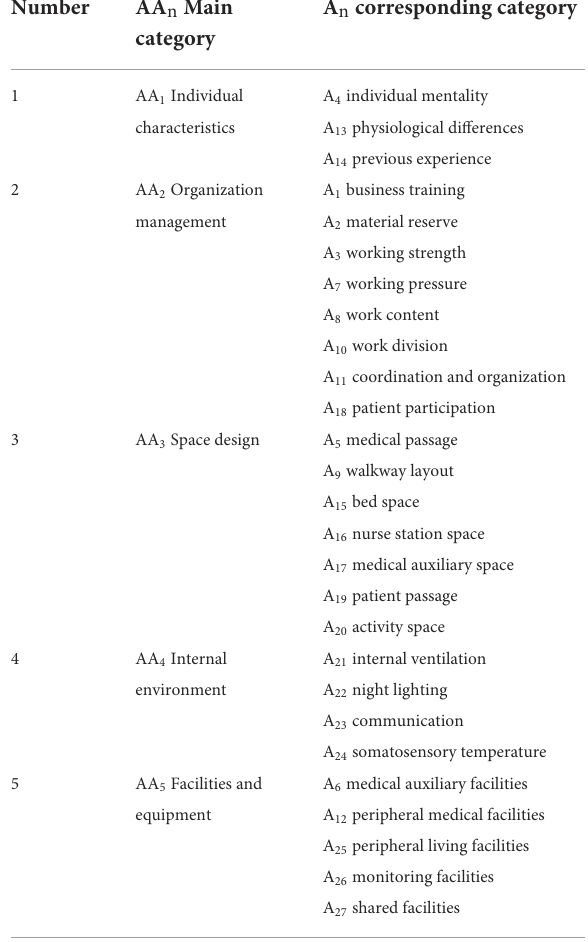
TABLE 3 Main category and corresponding